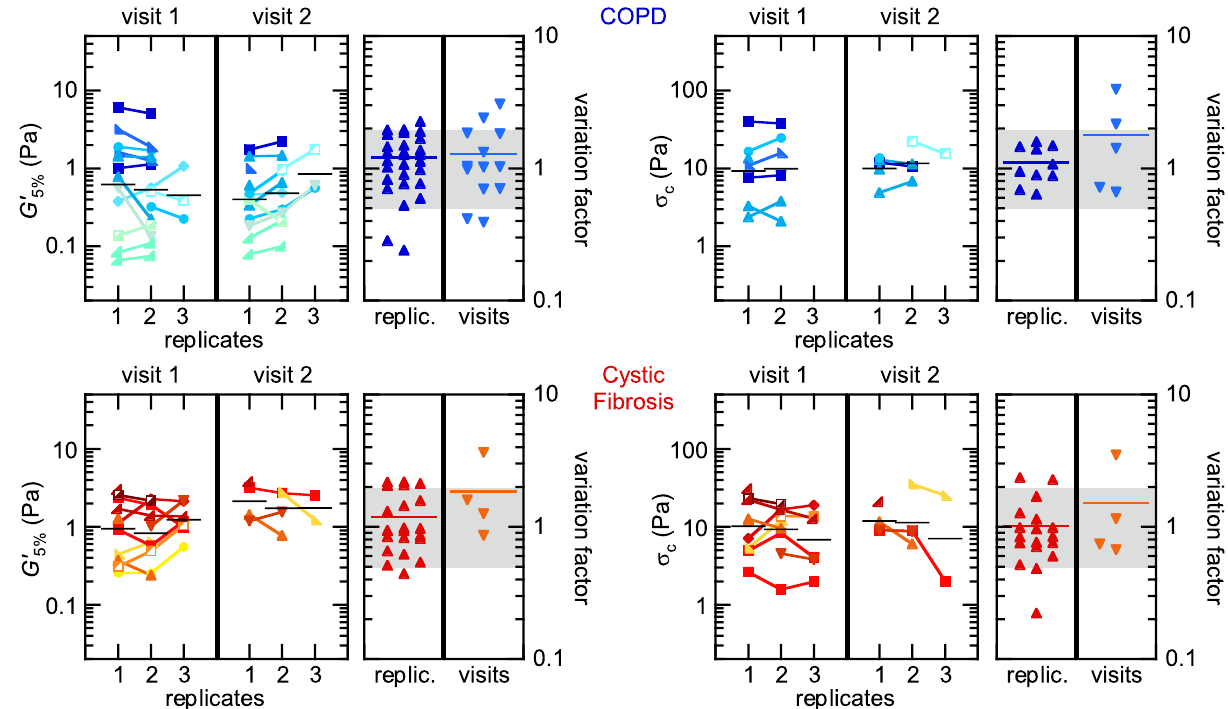
Figure 2. Temporal stability of sputum rheology. Evolution of the linear storage modulus, G ′ 5% , and critical stress, σ c , between consecutive replicates and between consecutive visits, for individual COPD (top) and CF patients (bottom). Each connected group of symbols corresponds to a single sputum sample; symbols are associated to individual patients. The horizontal bar in each replicate is the geometric mean. The variation 1 and n taken individually, and of replicated values in each visit (bar: mean factors are the ratios of replicates n + variation factor). The shaded area delimits variations (increase or reduction) by a factor smaller than two.